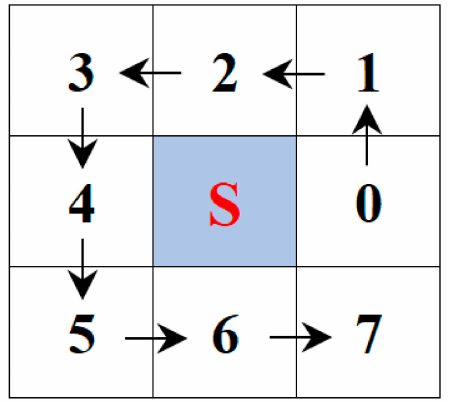
Figure 3. The flowchart of the eight-neighbor analytical